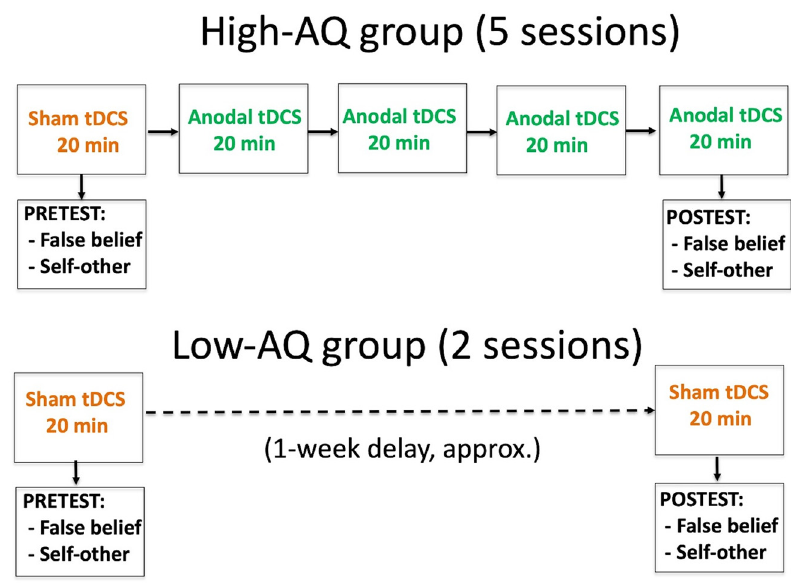
Figure 2. Experiment timeline for the high-AQ and low-AQ groups.